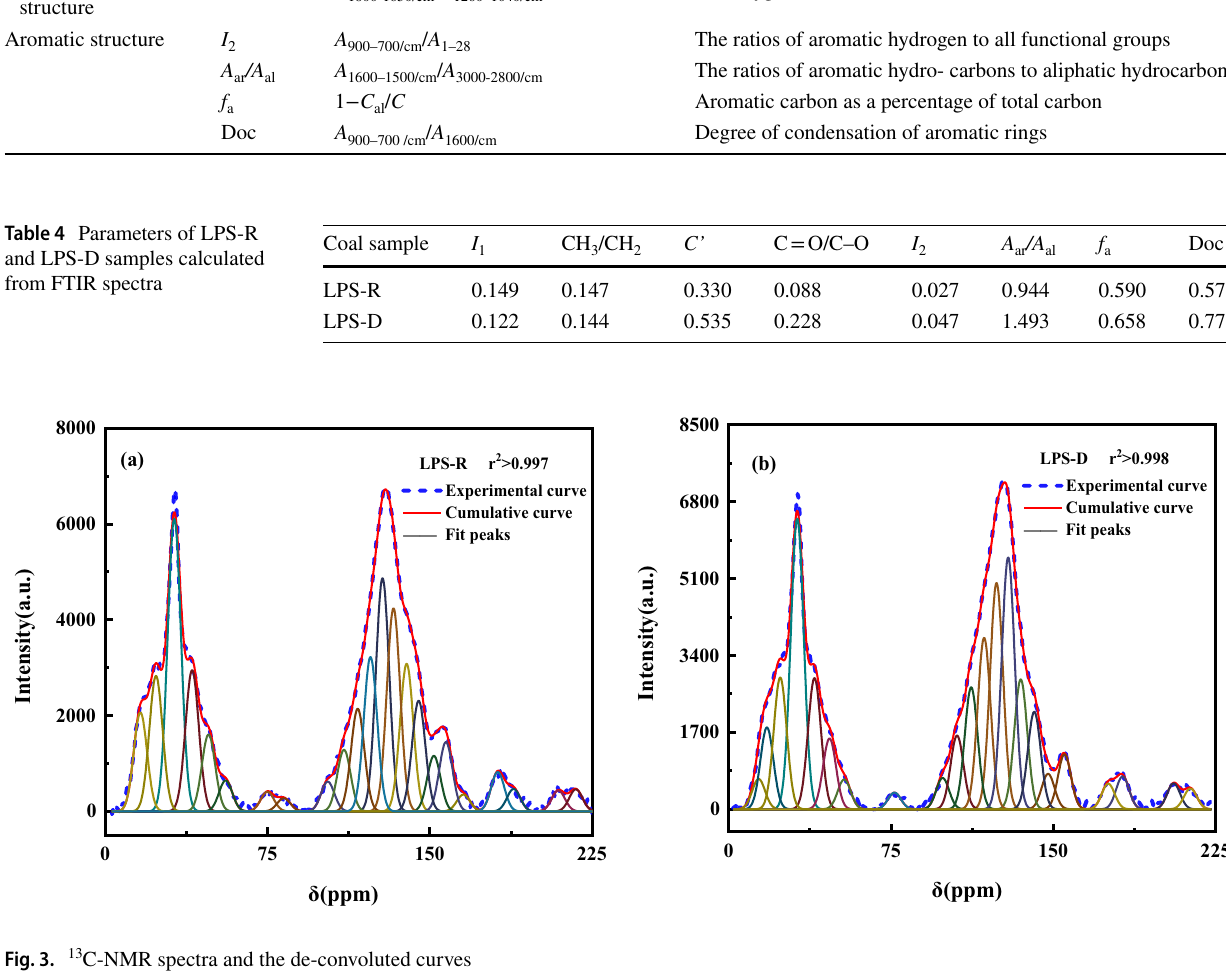
Fig. 3. 13 C-NMR spectra and the de-convoluted